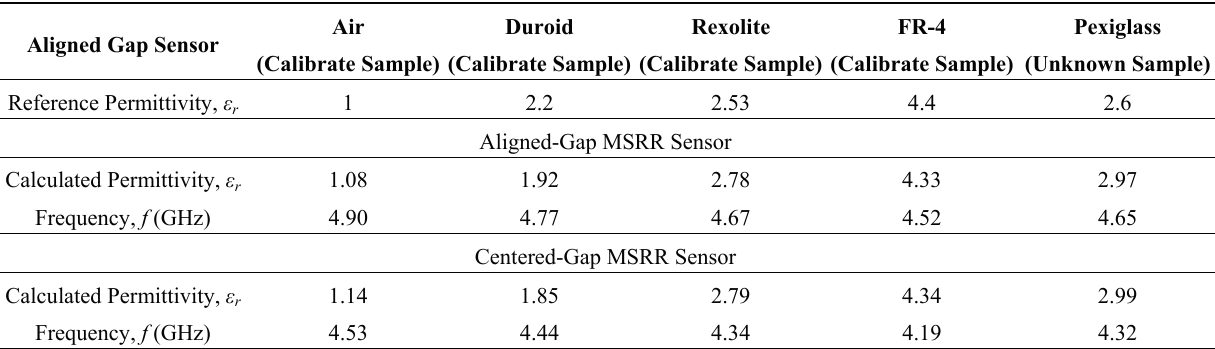
Table 4. Summarized experimental results for the aligned-gap and centered-gap sensor.